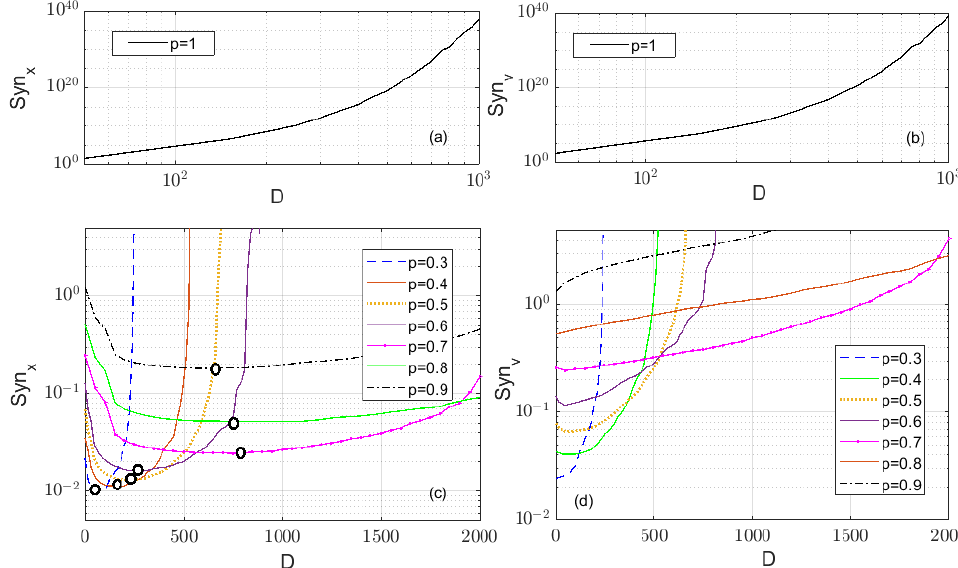
Figure 11. The average position/velocity synchronization error 𝑆𝑦𝑛 𝑥 ( a , c ) and 𝑆𝑦𝑛 𝑣 ( b , d ) curves of noise intensity D with different fractional-orders p (bounded uniform noise).